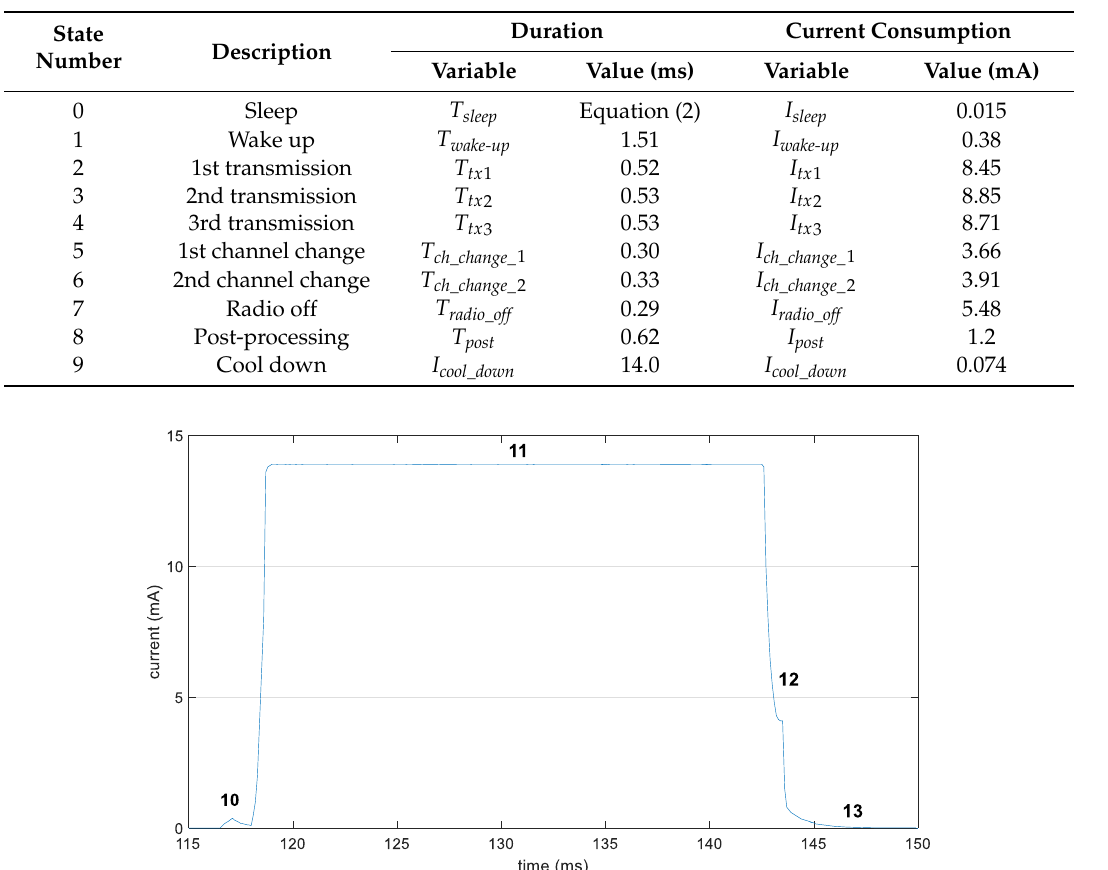
Figure 7. Current consumption of an nRF51422 Development Kit for the states related with performing a scan interval.